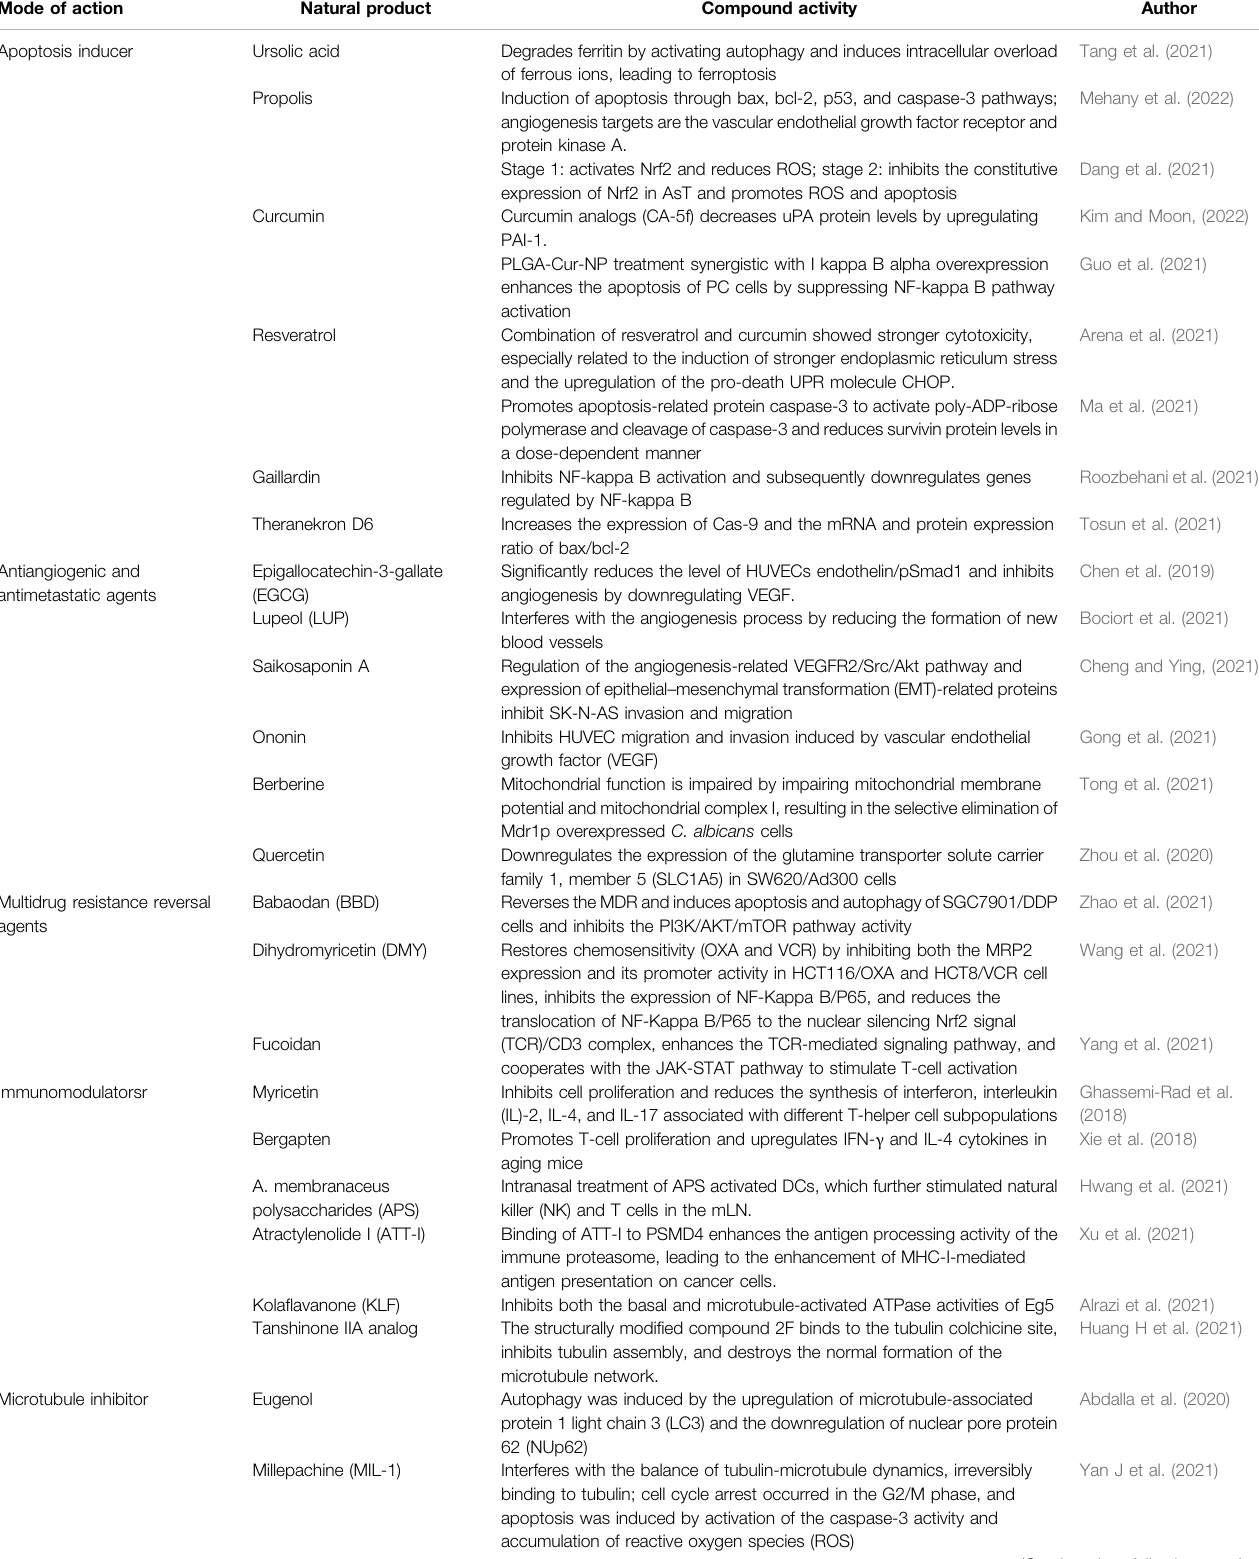
TABLE 7 | List of anticancer natural product classi fi cations based on pathways of action. Mode of